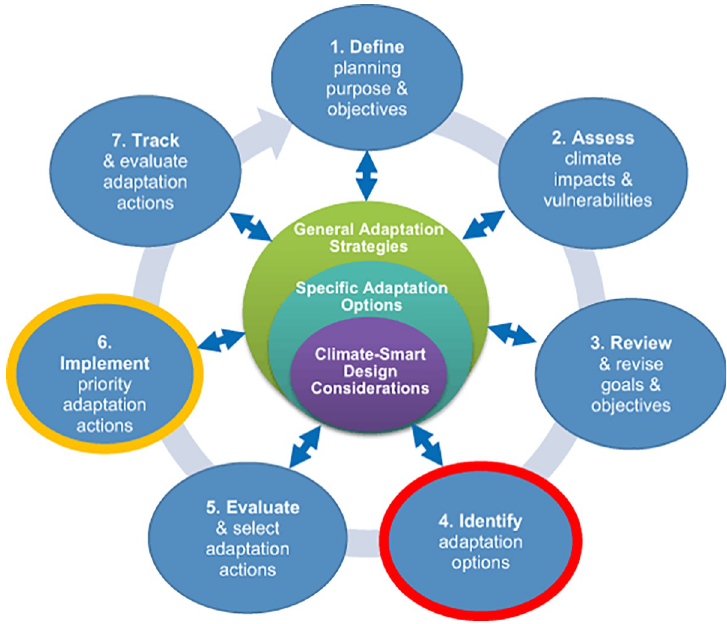
Fig 1. Climate-smart planning cycle with adaptation design framework. The Adaptation Design Tool [15] supports Steps 4 and 6 of the cycle, outlined in red and yellow, respectively.